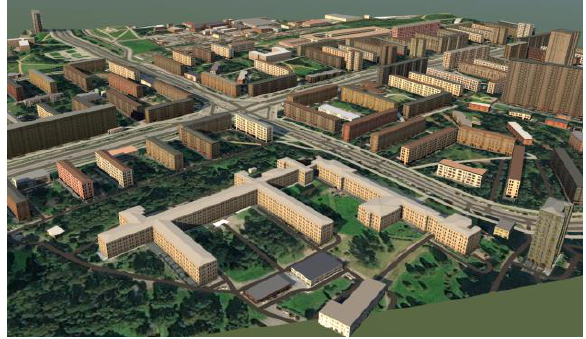
Figure 9. 3d model in